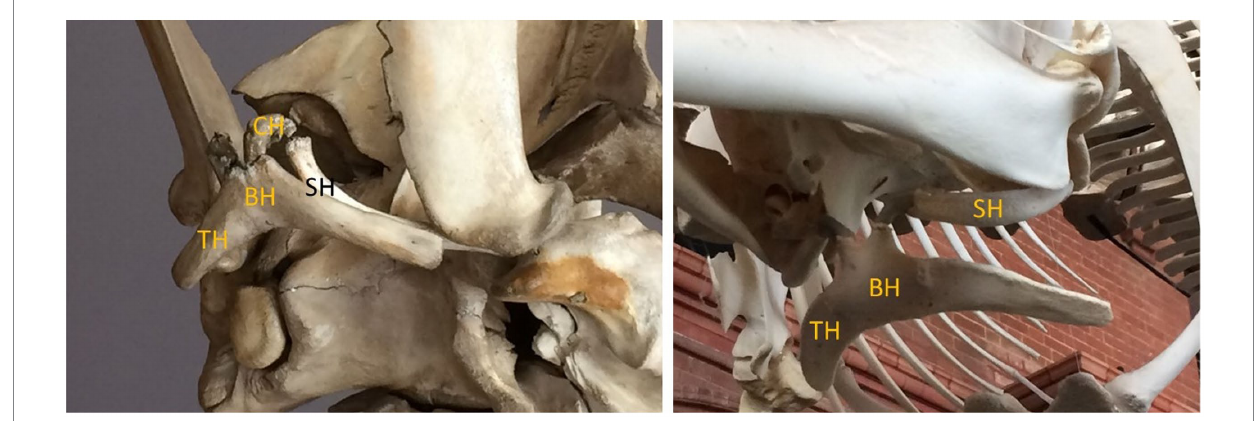
FIGURE 1 Cetacean hyoid skeletons of a mysticete (left, pygmy right whale, Caperea marginata ) and odontocete (right, killer whale, Orcinus orca ) in ventral view showing two cornua (horns) with fused elements: BH, basihyal; TH, thyrohyal; CH, ceratohyal; SH,